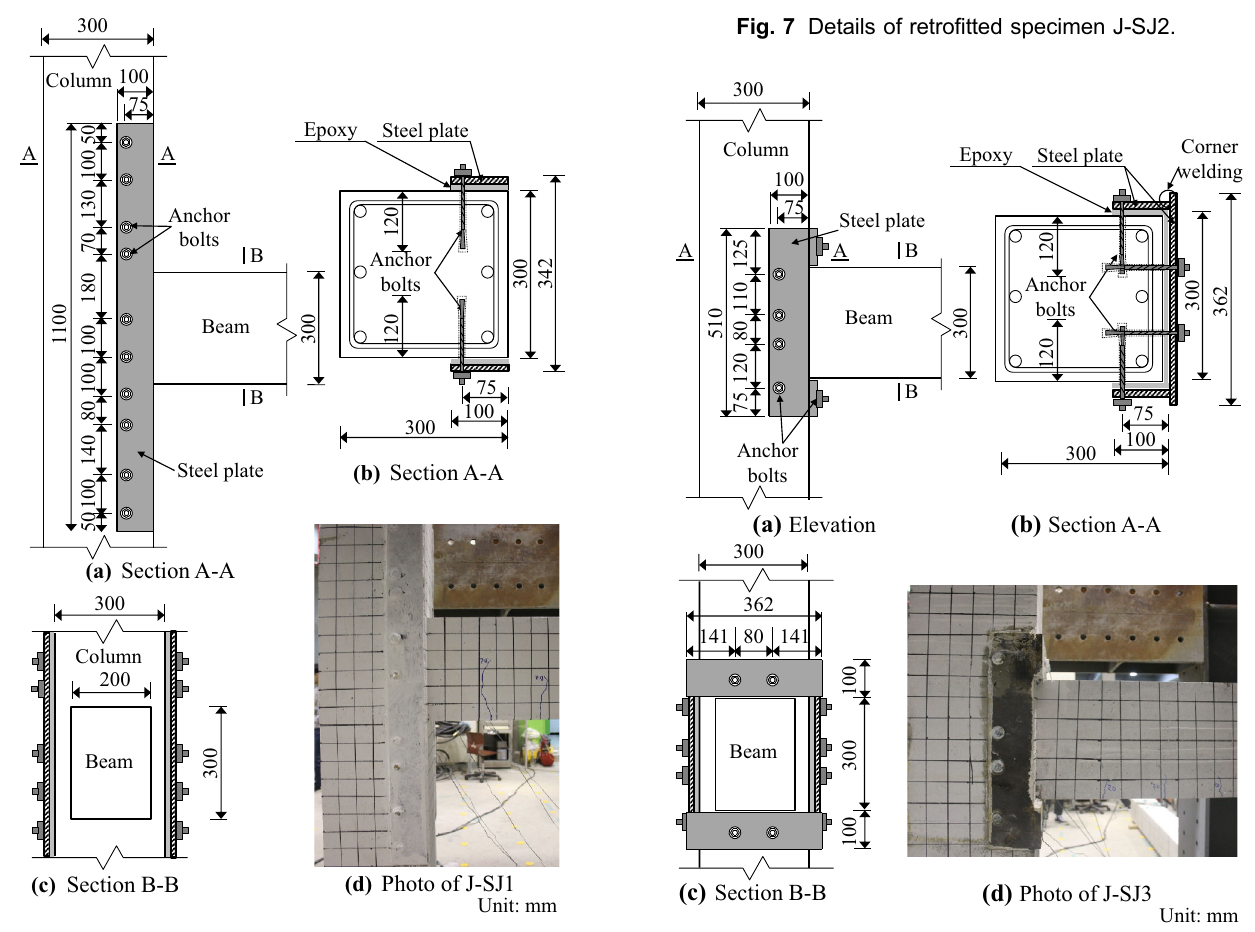
Fig. 8 Details of retrofitted specimen